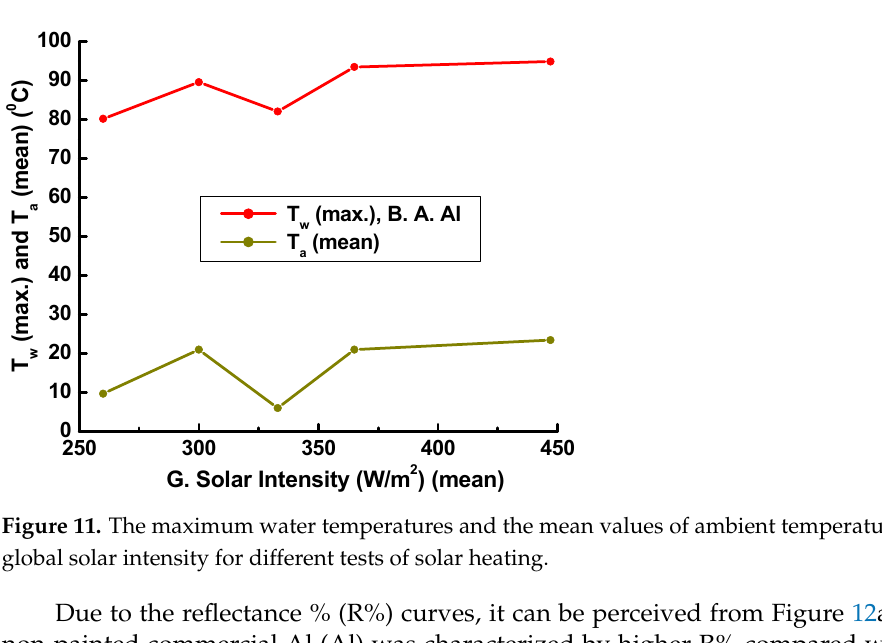
where C is the intercept, λ is the wavelength, and B 1 , B 2 , B 3 and B 4 are the equation con- stants.